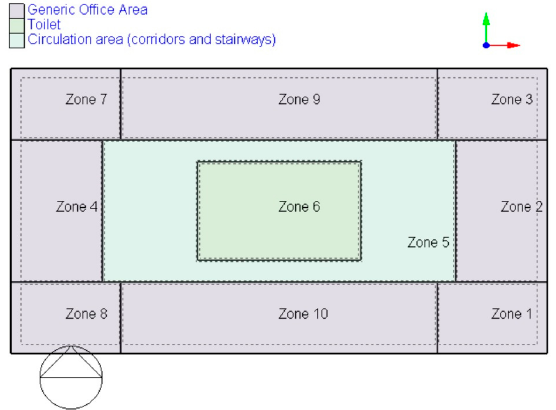
Figure 4. Floor subdivision in thermal zones.